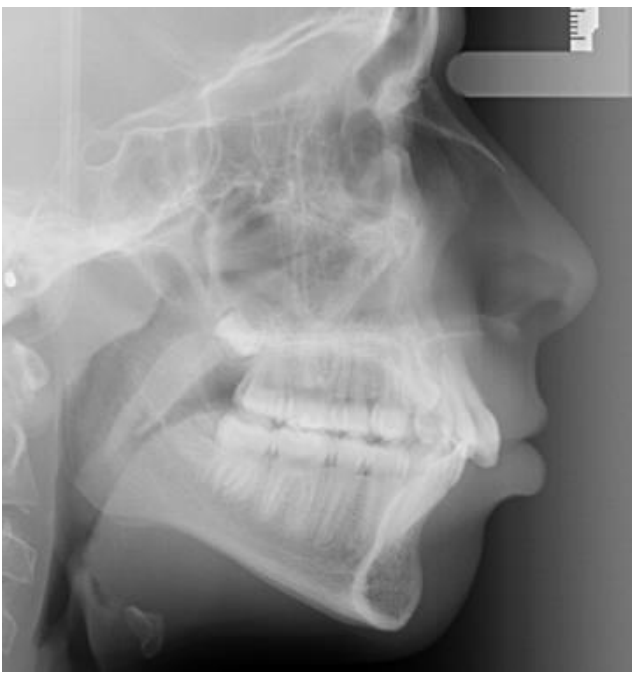
Figure 2. Full sella bridging.